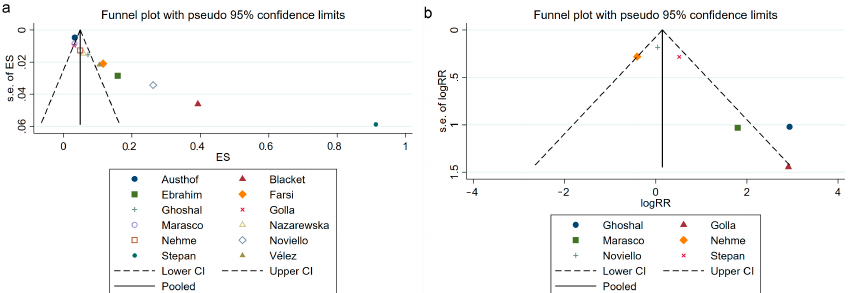
Figure 6. Publication bias evaluation. Funnel plot of the IBS prevalence after SARS-CoV-2 infection ( a ) [19–24,33–38]. Funnel plot of the association between IBS and SARS-CoV-2 infection ( b ) [22,23,34–36,38]. IBS, irritable bowel syndrome; SARS-CoV-2, severe acute respiratory syndrome coronavirus 2; P, prevalence of IBS following SARS-CoV-2 infection; RR, risk ratio.